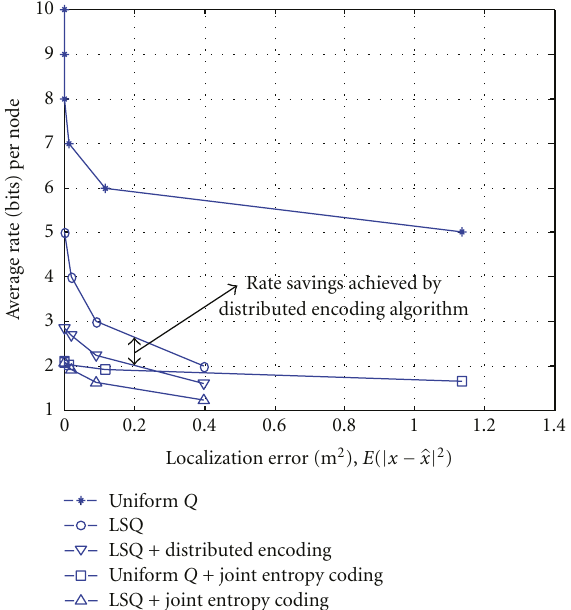
Figure 11: Performance comparison: distributed encoding algo- rithm is lower bounded by joint entropy